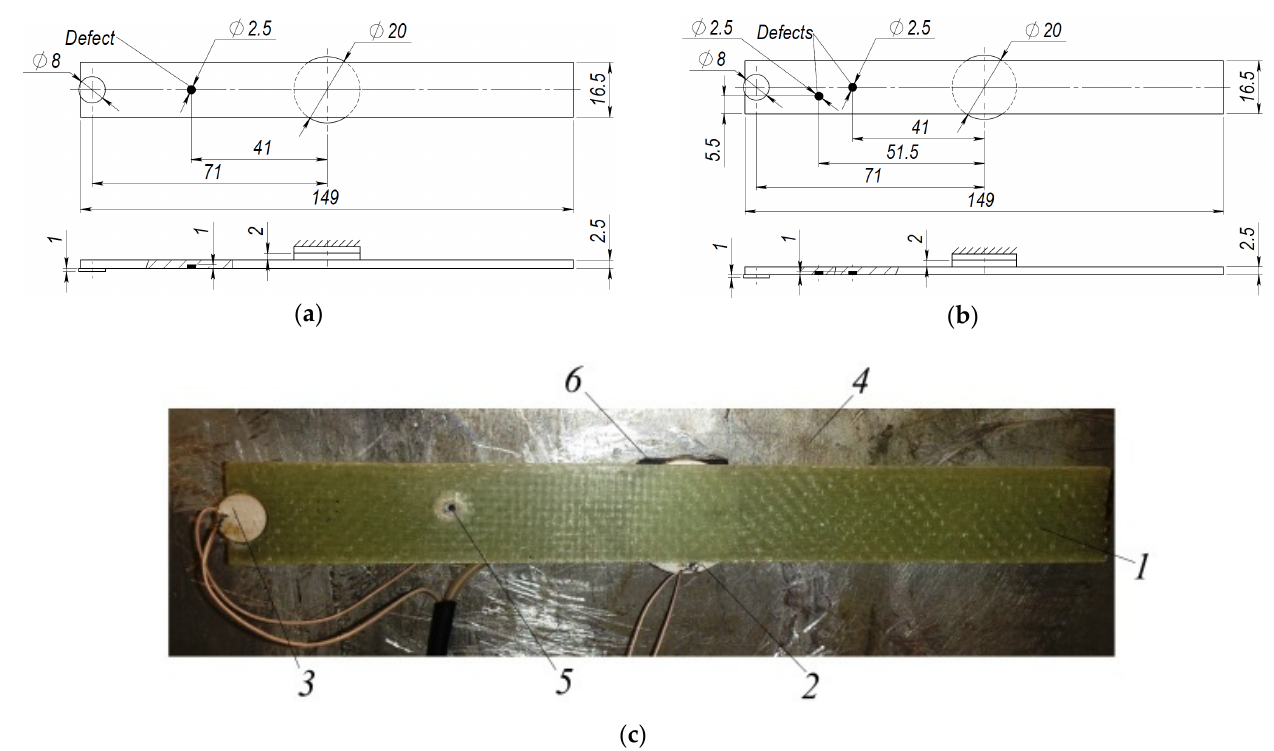
Figure 7. Details of the composite plate with defect: ( a ) Dimensions of the composite plate with one defect; ( b ) Dimensions of the composite plate with two defects; ( c ) View of the composite plate with one defect: 1—composite plate, 2—disc-shaped piezoelectric transducer (as the actuator) for exciting the structure, 3—piezoelectric transducer (as the sensor) for plate vibration measurement, 4—aluminum base, 5—defect, 6—soft material isolation layer between piezoelectric actuator and aluminum plate.